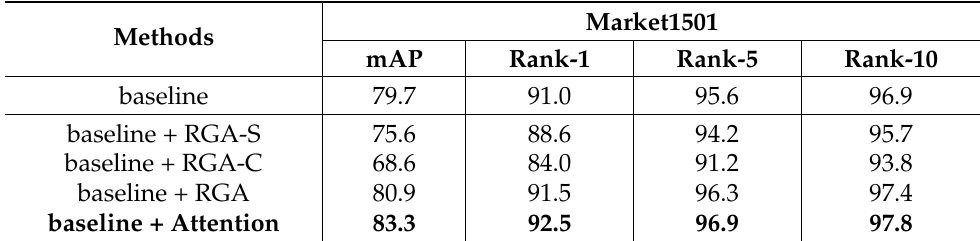
Table 6. Performance comparisons of our attention model with the baseline and other attention module designs. RGA-S and RGA-C, respectively, represent that only the spatial attention mechanism and the channel attention mechanism are used for relation-based features.